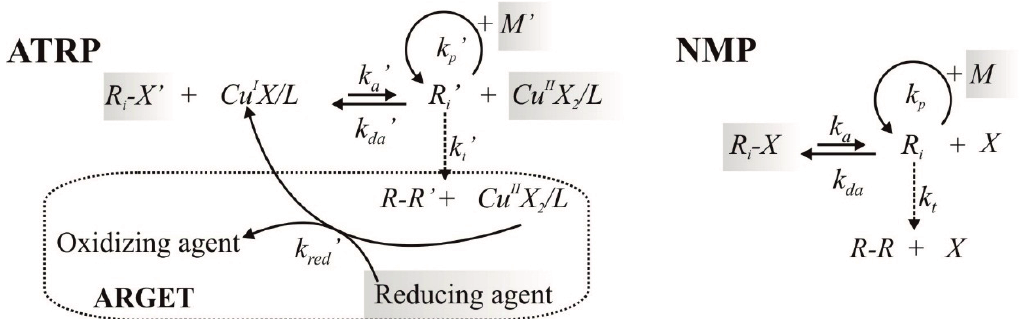
Figure 1. Left : basic reaction scheme for Activators ReGenerated by Electron Transfer (ARGET) Atom Transfer Radical Polymerization (ATRP) using a Cu-based catalyst ( Cu II X 2 / L ; deactivator ) and as ATRP initiator R 0 X ' (X: halogen atom), and monomer M '; Right : basic reaction scheme for Nitroxide Mediated Polymerization (NMP) using an alkoxyamine initiator R 0 X and monomer M ; k : rate coefficient; a , da , p , red , t : activation, deactivation, propagation, reduction, and termination; i : chain length with i = 0 initiator related; grey box: initial presence of this species ( i = 0); for simplicity only termination by recombination is shown; in traditional ATRP no reducing agent and also activator present at the